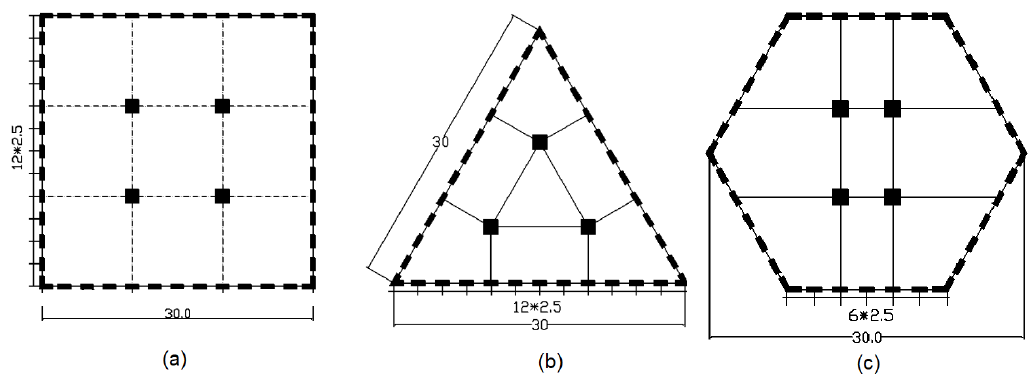
Figure 1. Three different plan shapes: ( a ) rectangular, ( b ) triangular and ( c ) hexagonal (all dimensions are in meters).